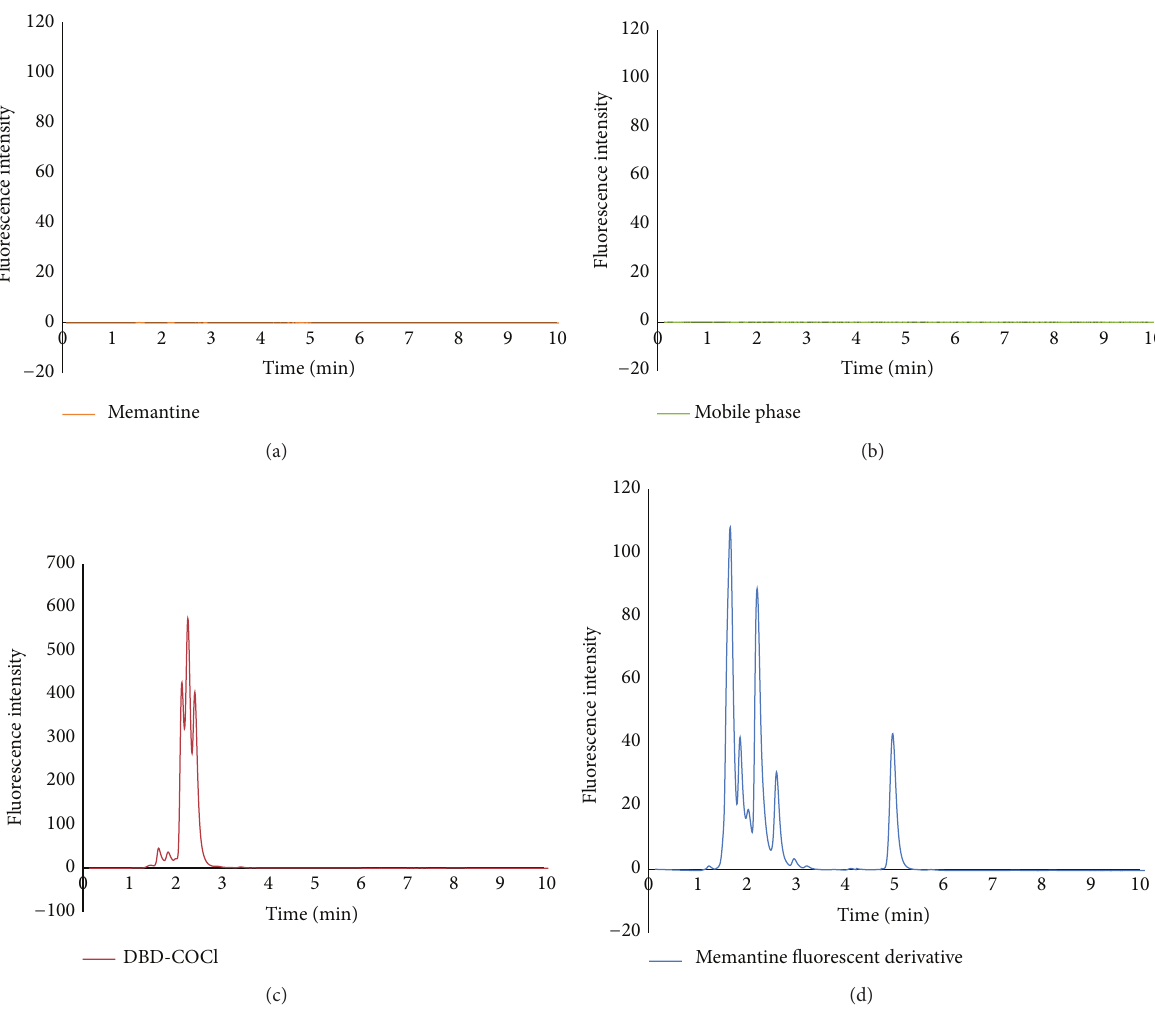
Figure 6: Chromatograms of (a) memantine, (b) mobile phase, (c) DBD-COCl, and (d) memantine fluorescent derivative. HPLC condition: see Section 2.3.